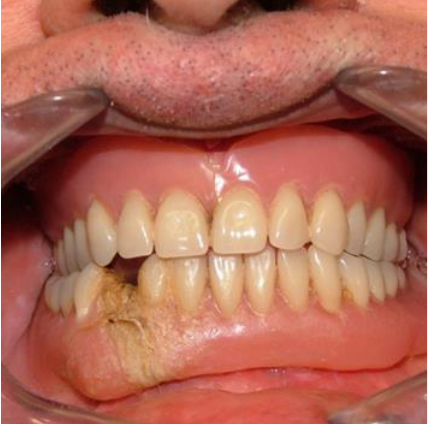
Figure 2. Intraoral view of the prosthesis repaired by the patient.